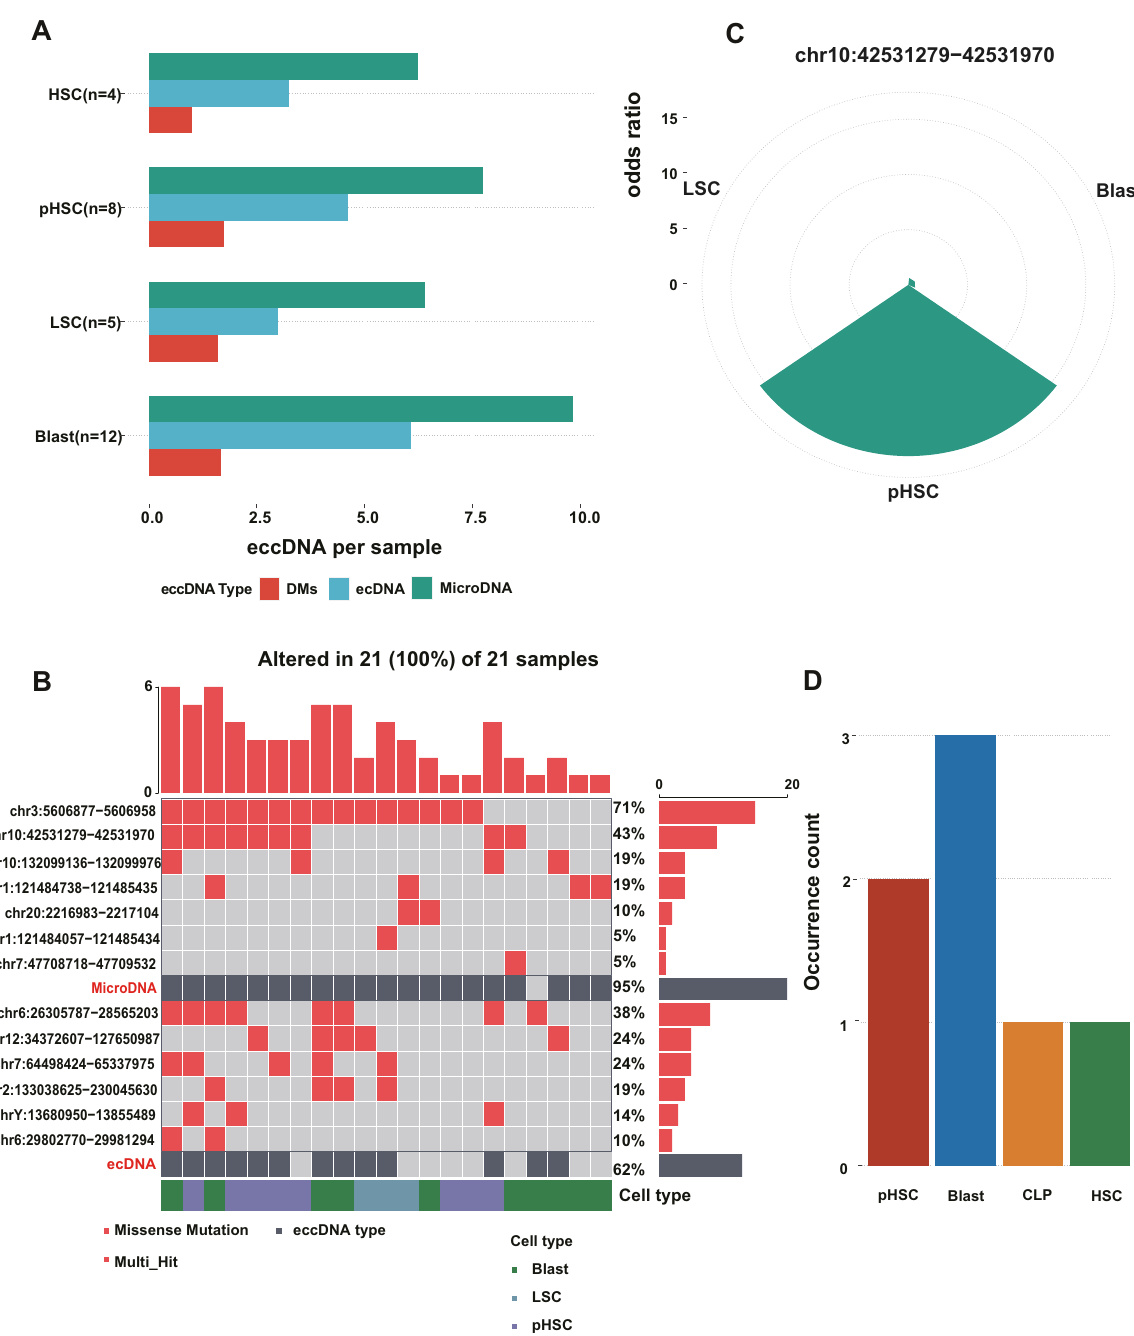
Fig. 4 The recurrent eccDNA across four cell types of leukemia evolution. A The barplot revealed the average number of eccDNA in four cell types (including HSC, pHSC, LSC, and Blast) of leukemia evolution. The X-axis represents the cell type; Y-axis represents the average number of eccDNA (the eccDNA types are shown in different colors). B Oncoplot depicted the eccDNA landscape of leukemia evolution. The eccDNAs on the left were ordered according to the proportion of cells with that eccDNA in all cells. The samples at the bottom indicate according to the annotation bar (linkage and cell types). The sidebar plot represents the proportion of cells with eccDNA. C The barplot demonstrated micoDNA (chr10:42531279 − 42531970) was enriched in pHSC ( P = 0.004). D The occurrence count of micoDNA (chr10:42531279 − 42531970) in all cells of normal hematopoiesis and leukemia evolution. The micoDNA (chr10:42531279 − 42531970) only occurred in HSC, CLP, pHSC, and blast. The X-axis represents the cell type; Y-axis represents the occurrence count of the micoDNA (chr10:42531279 − 42531970) in a different different expressed AML-speci fi c and normal-speci fi c genes. The The recurrent and speci fi c eccDNAs in AML and normal cells result demonstrated that AML-speci fi c genes signi fi cantly differ- To reveal the difference between eccDNAs in AML and normal entiate the normal groups, and AML samples clustered tightly with cells, we found the number of genes on eccDNAs of AML was each other. (Fig. 7B). Moreover, GO enrichment identi fi ed that close to 300. The number was far more than normal cells (Fig. 7A). differentially expressed genes on eccDNAs of AML were enriched Heatmap showed the hierarchical clustering analysis of the